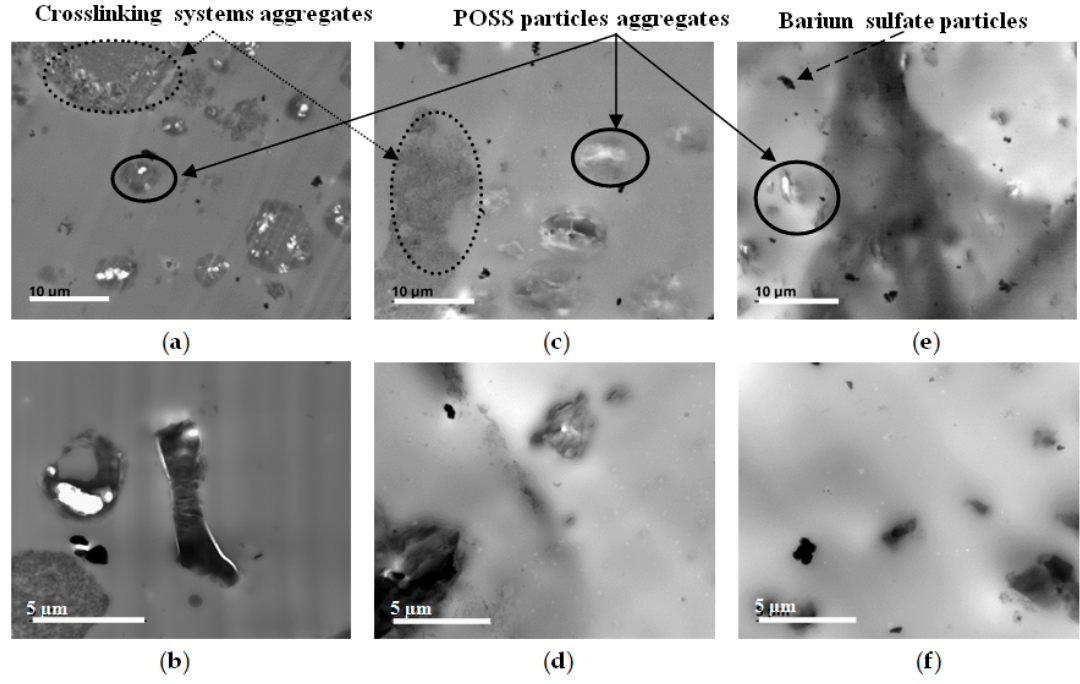
Figure 3. Transmission electron microscopy (TEM) micrographs of POSS nanocomposites. ( a , b ) F TA-20 , ( c , d ) F TP-20 , ( e , f ) F TF-20 (POSS content 20 phr).